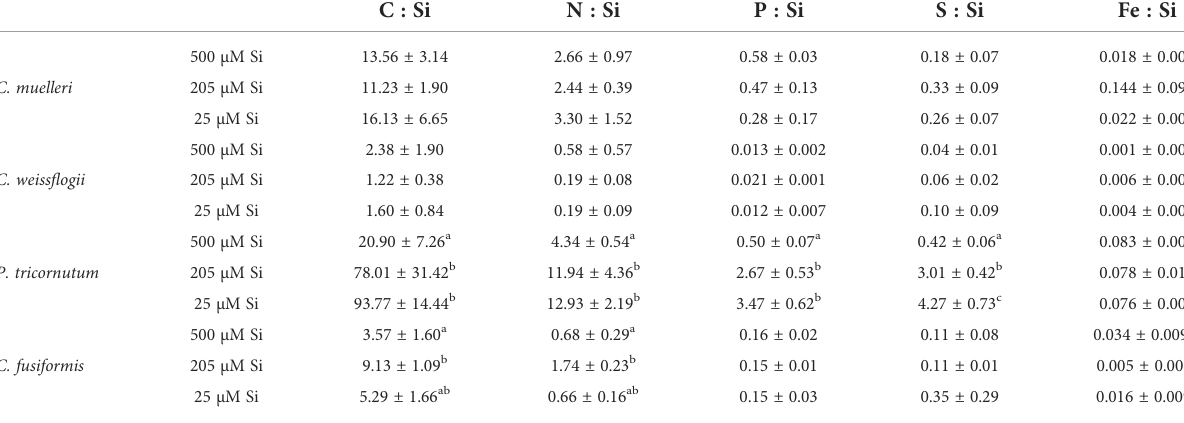
TABLE 4 Cell stoichiometry in relation to Si content (pg·cell -1 ) of the four diatoms acclimated to different paleoenvironments. C :